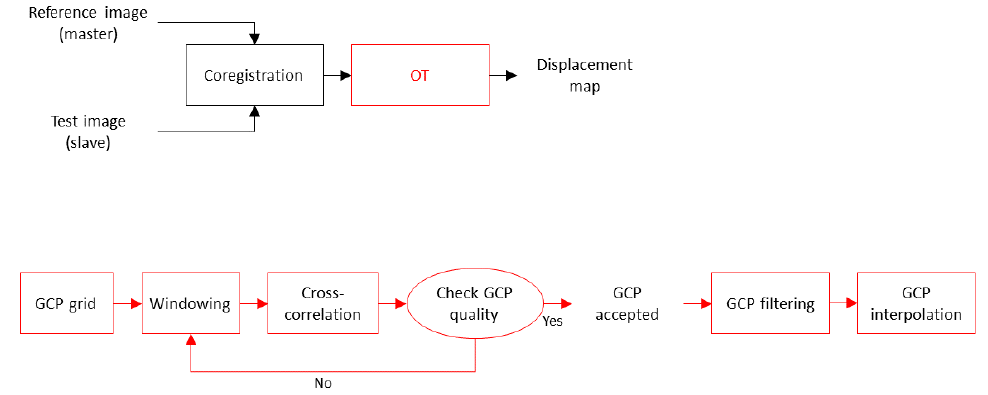
Figure 1. Block diagram of the implemented frequency-domain offset tracking (OT) technique. The lower diagram is an exploded view of the OT processing block.